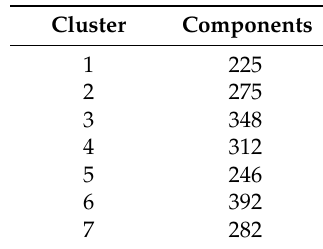
Table 1. Results of the clustering process.